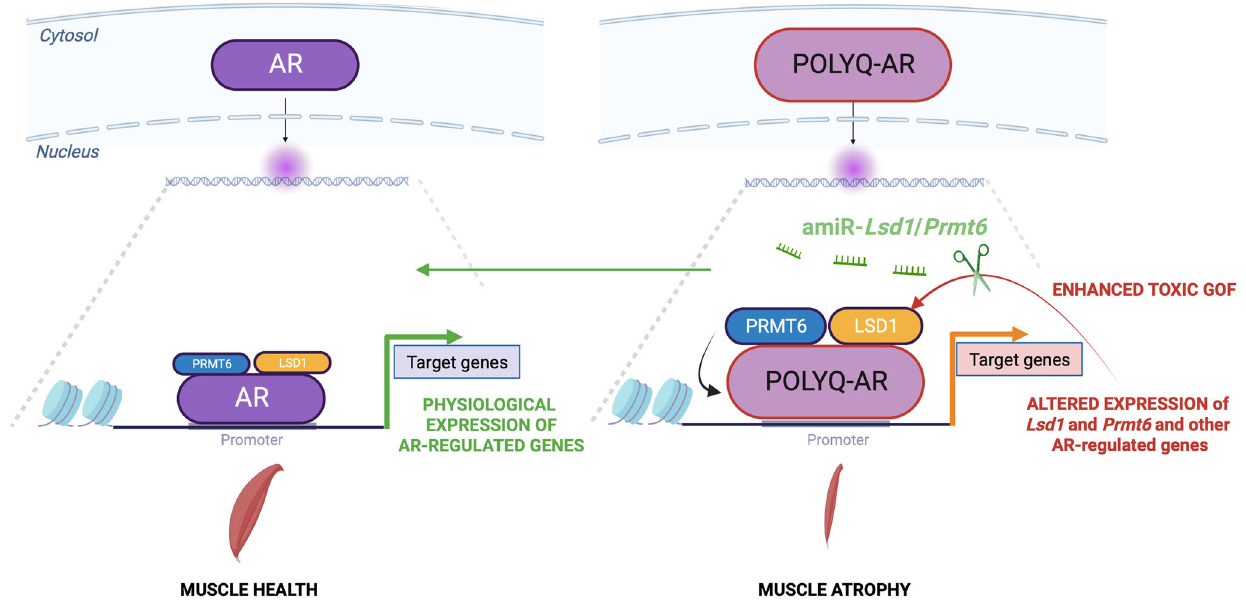
Fig. 10 | Working model of polyQ-expanded AR and co-regulators in SBMA muscle. Inphysiologicalconditions, AR controls expressionof targetgenes.PolyQ expansions result in aberrant transcription of AR co-regulators, such as LSD1 and